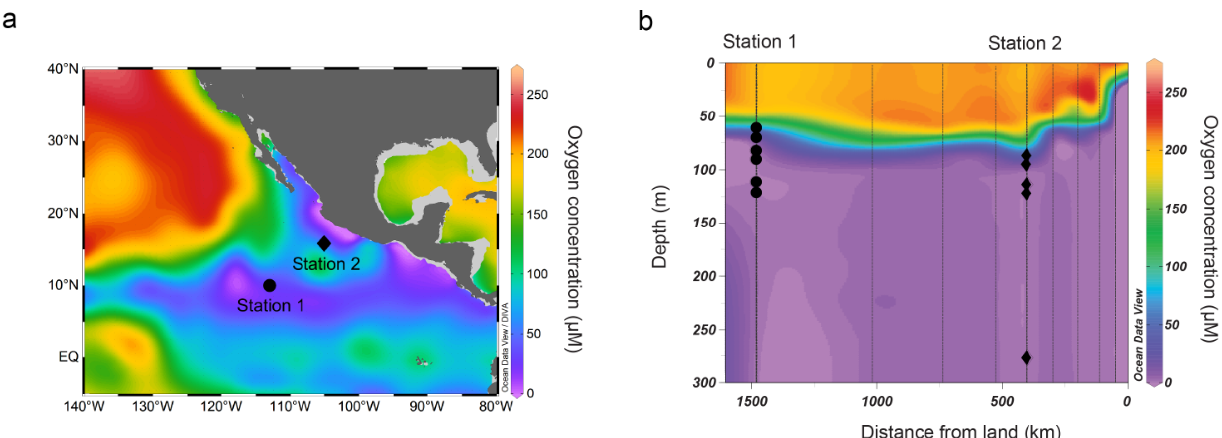
Figure 1. ( a ) Sampling locations in the eastern tropical North Pacific (ETNP) oxygen minimum zone. Color contour shows oxygen concentrations at 100 m depth from World Ocean Atlas 2013 (March average from 1955–2012) [24]. ( b ) Depths sampled for nitrous oxide (N 2 O) production experiments are marked by filled symbols. Color contour shows oxygen concentrations measured during this cruise using a Seabird SBE 43 dissolved oxygen sensor. filtered through a 47 mm Whatman Grade 541 acid-hardened cellulose filter paper (22 μ m nominal particle retention rating, GE Healthcare 1541–047, Marlborough, MA, USA), a 47 mm polycarbonate filter (2.0 μ m nominal pore size, Millipore Isopore TTTP-04700,